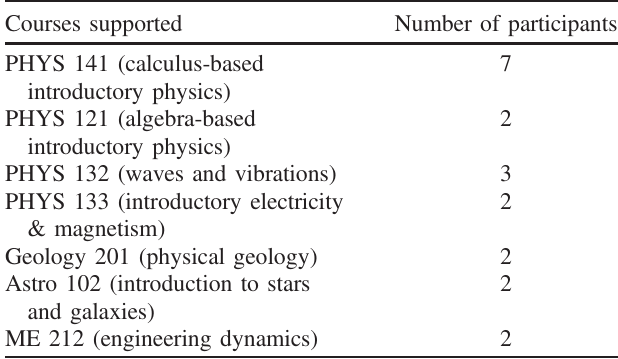
TABLE III. Overview of courses the LA participants